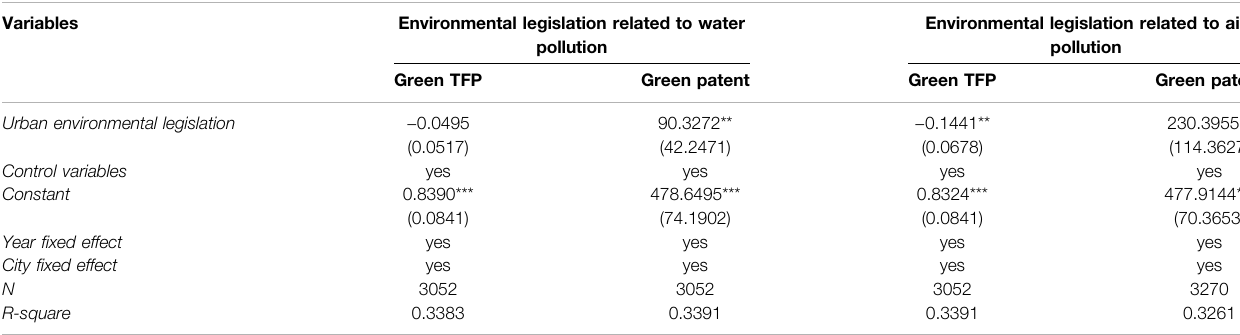
TABLE 9 | Impact of different types of environmental legislation on green innovation.